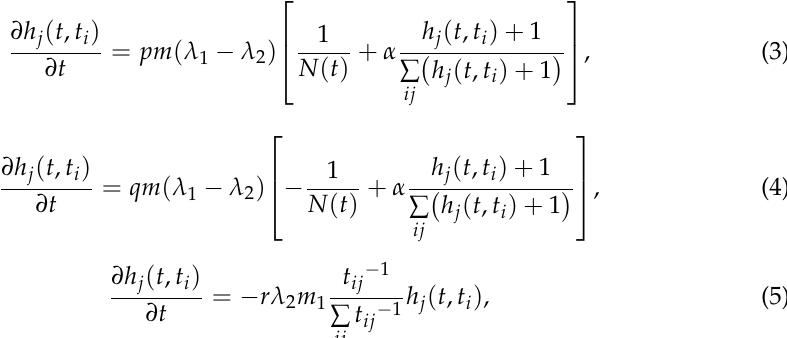
* e represent the information 1 represent the information 1